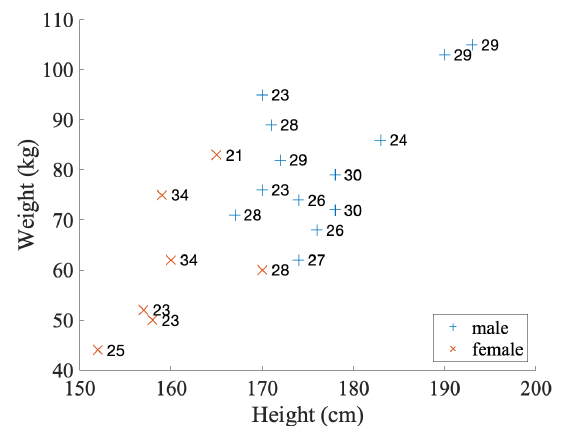
Figure 9. Demographic distribution (The age is written to The right side of every marker.)